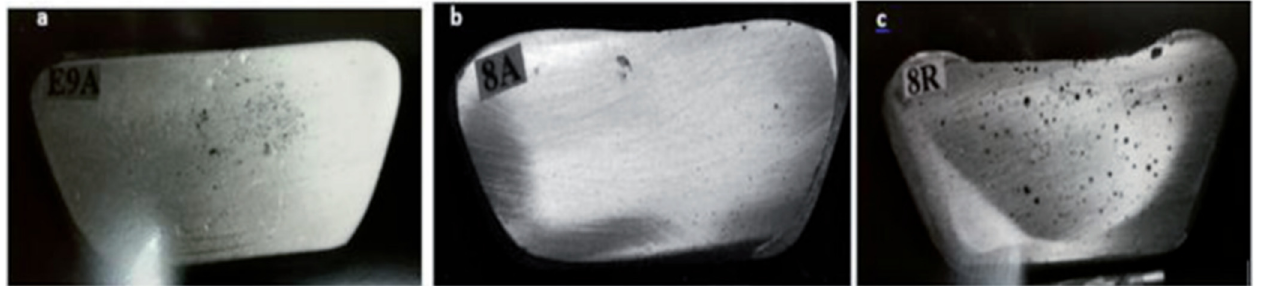
Figure 4. RPT test taken from melts of ( a ) as-received 319 alloy; ( b ) after degassing; ( c ) melt contain- ing 0.25 mL/100 g Al. 0.25 mL/100 g